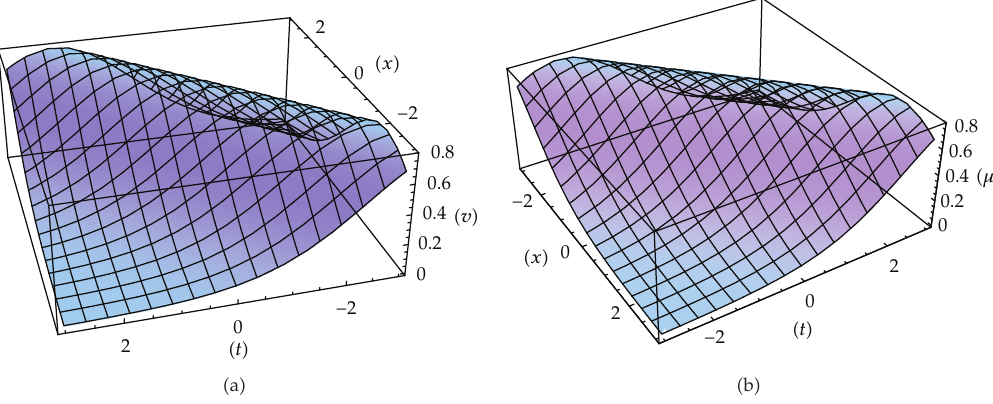
Figure 1: Profile of the solitary wave solution (cid:3) 2.12 (cid:5) - (cid:3) 2.13 (cid:5)